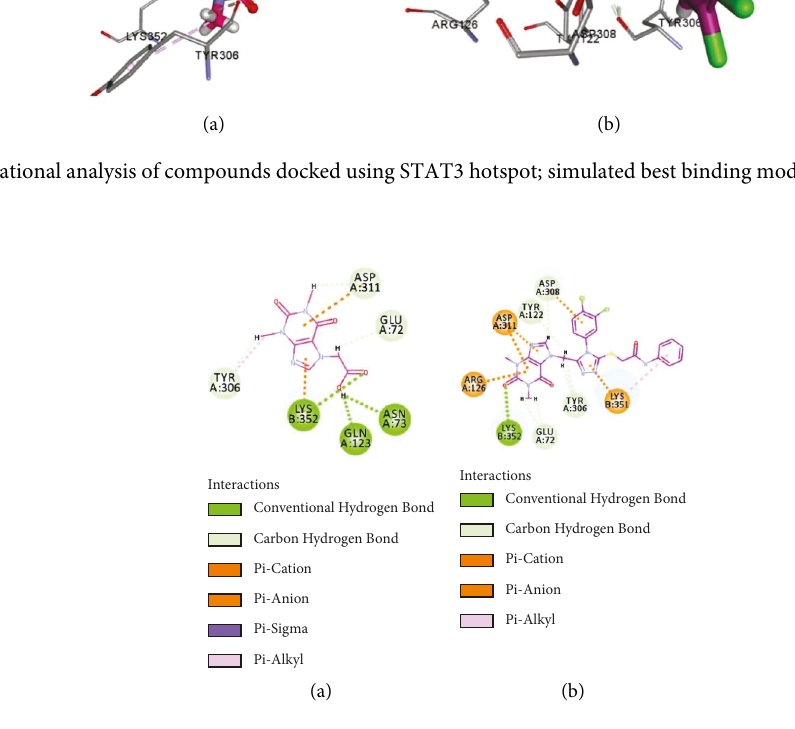
Figure 4: Interaction within the binding pocket of STAT3 hotspot of (a) 2 and (b) 9e . Two-dimensional (2D) perspective on docked compounds’ interaction with STAT3 key residues illustrated as balls and sticks colored by type of interaction.